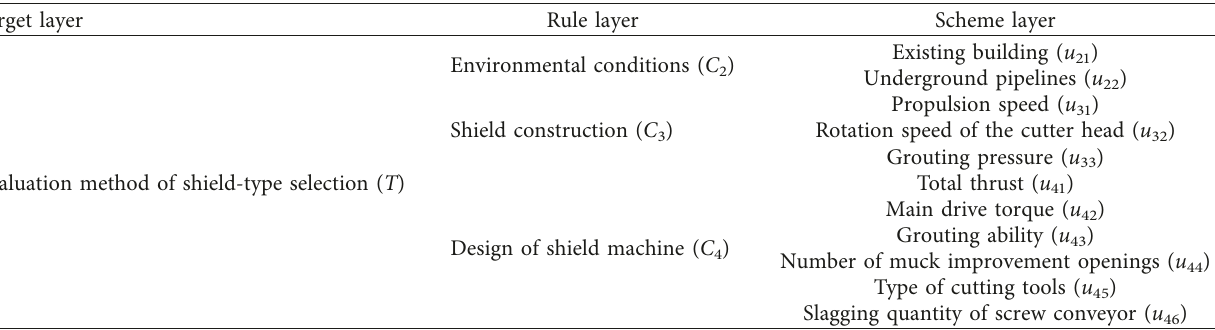
Table 8: Final evaluation